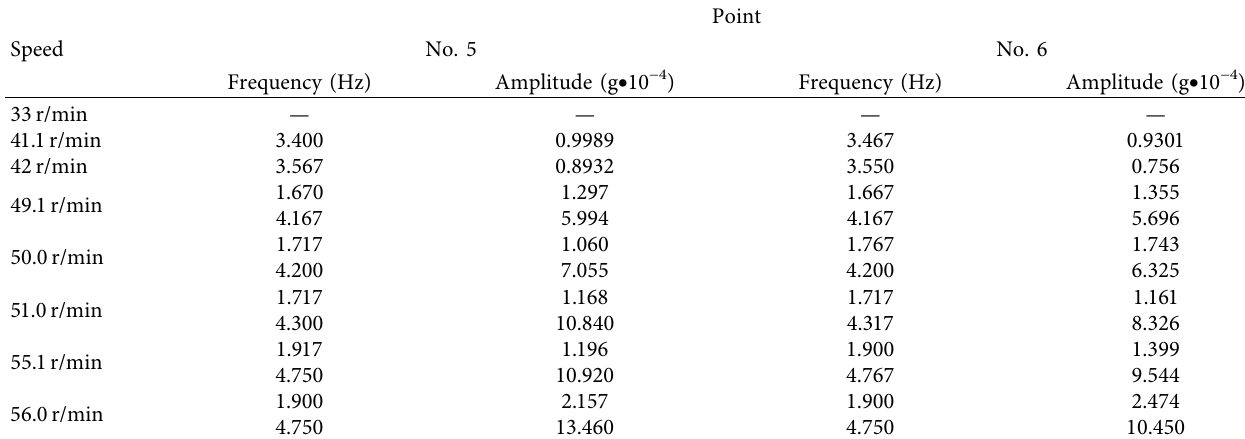
Figure 9: Main parameters of hull vertical vibrations. (a) Frequency (b) Amplitude. Table 2: Main datum of hull vertical vibrations.